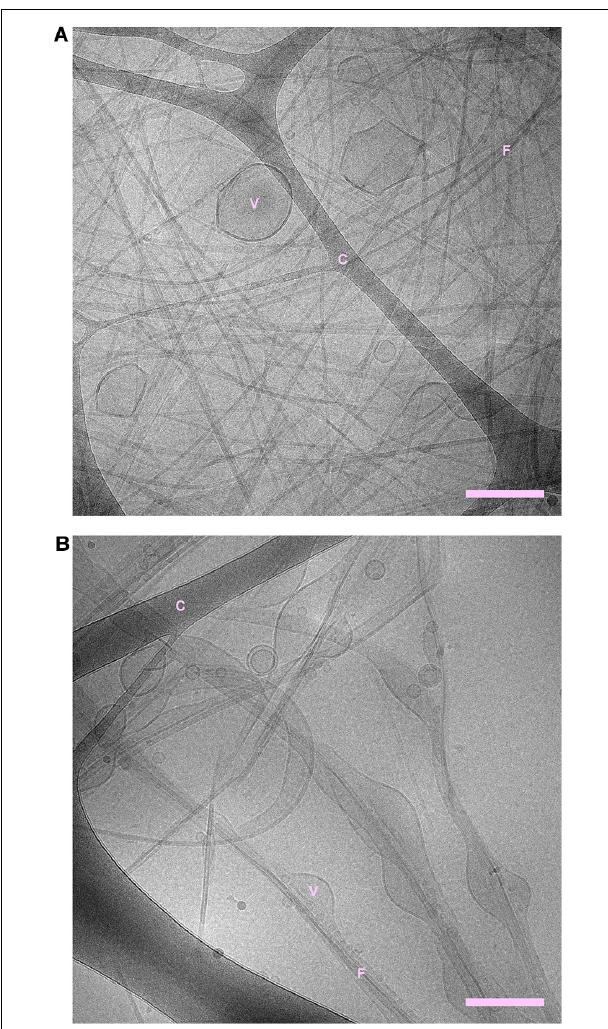
FIGURE 2 | (A) NACore fibrillated in the absence of phospholipids. (B) POPC:POPS vesicles in the absence of NACore. (C) POPC vesicles in the absence of NACore. POPC vesicles were mainly found associated with the cryo-TEM carbon grid, rather than free in the solution. “C” denotes the cryo-TEM carbon grid, “F” denotes fibrils, “V” denotes vesicles, and “E” denotes suspected ethane contamination (not part of the sample itself). Scale bars show 200